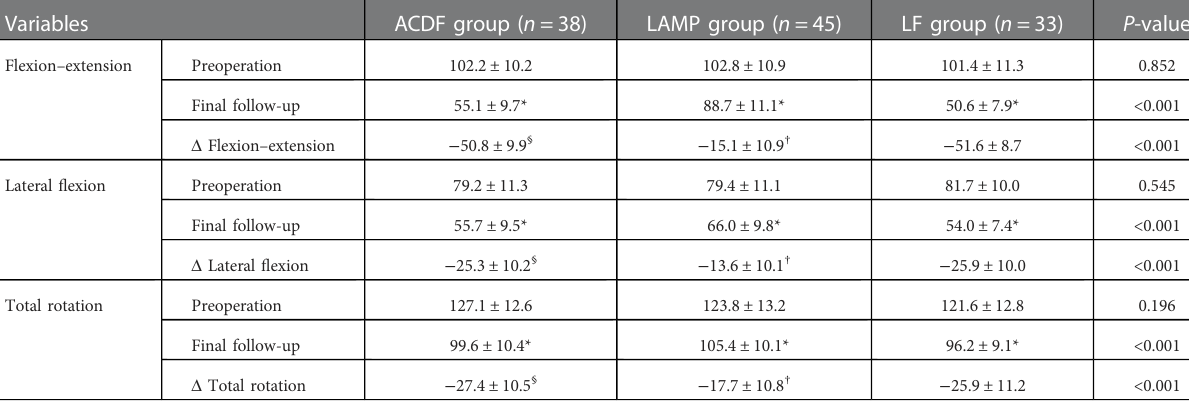
TABLE 4 Active cervical ROM measurement in each